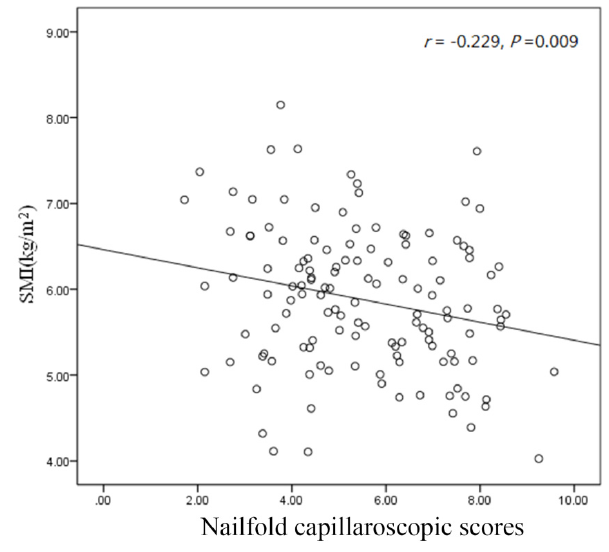
Fig. 3. Correlation between SMI and nailfold capillaroscopic score. Scatter plot indicates a negative correlation between SMI and nailfold microcirculation score (r= -0.229, P